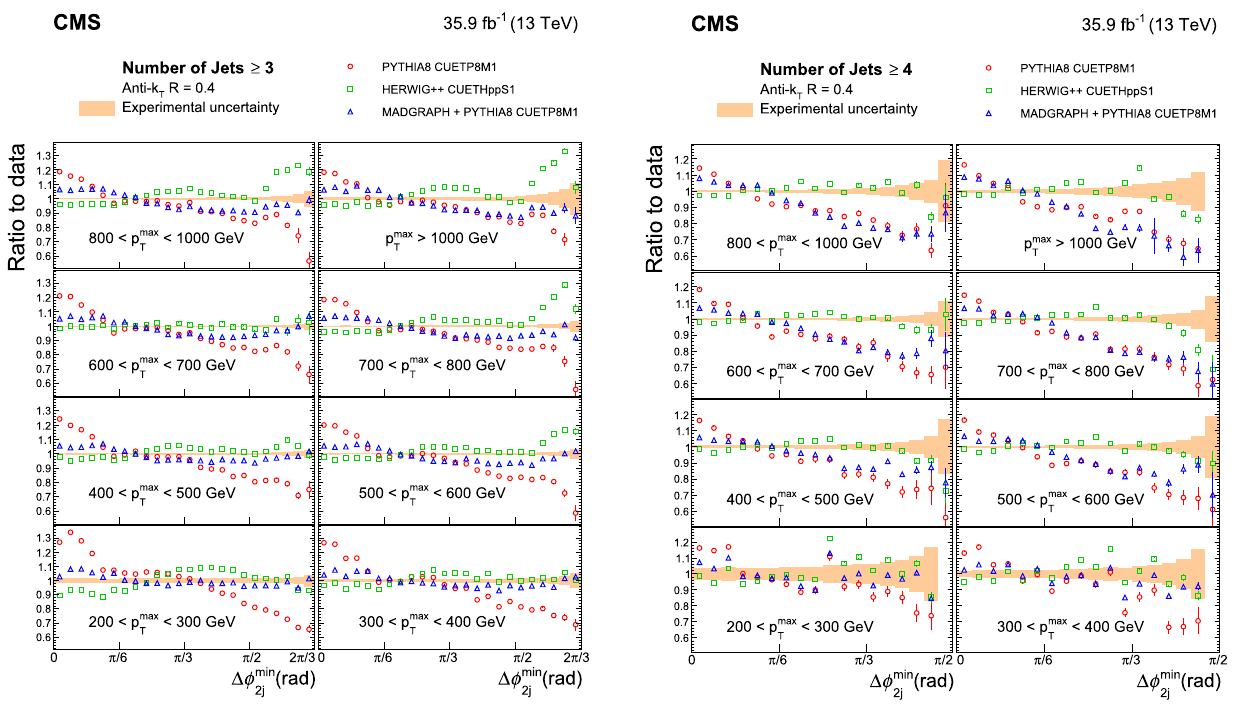
Fig. 13 Ratios of pythia 8, herwig++ , and MadGraph + pythia 8 predictions to the normalized inclusive 4-jet cross section differential in Δφ min , for all p max regions. The solid band indicates the total exper- 2j T imental uncertainty and the vertical bars on the points represent